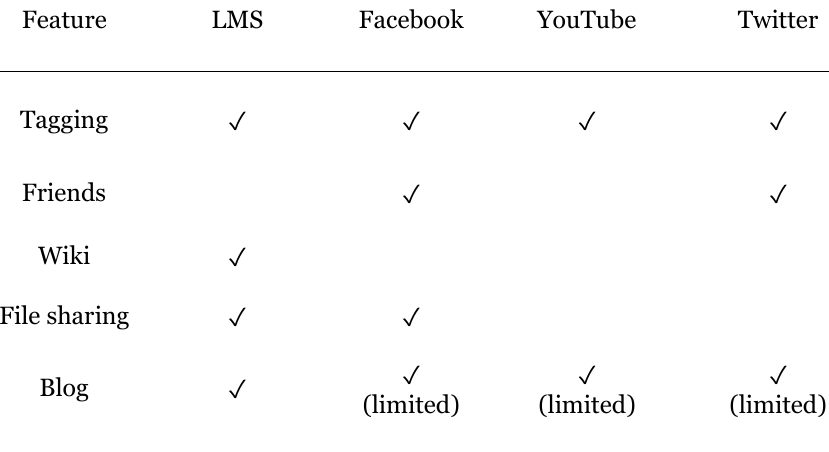
Features of an LMS and Online Social Networking Platforms